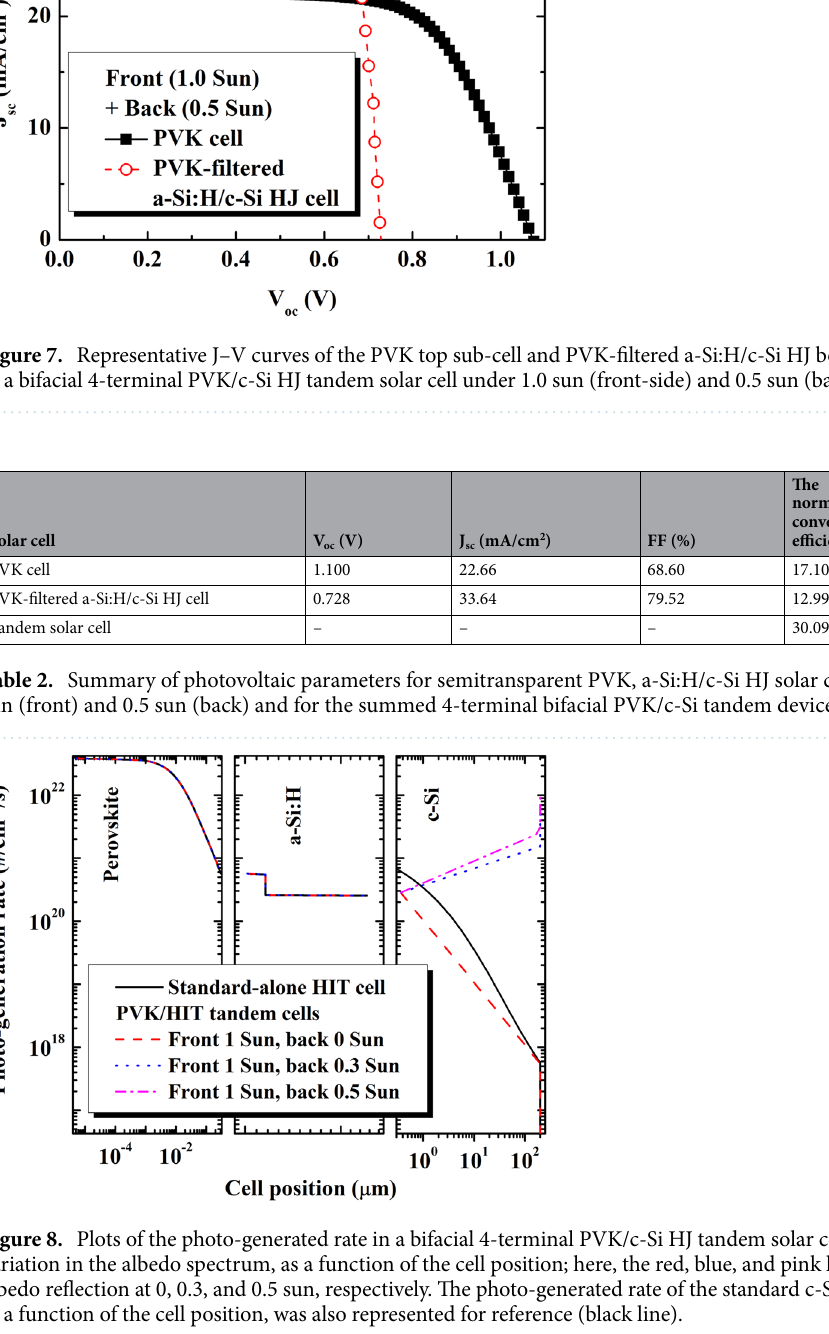
version efficiency. Figure 8 shows the simulated photo-generated rate distribution, which was determined using AFORS-HET software, within the PVK/c-Si HJ tandem solar cell under three selected conditions: without spec- tra albedo (dashed red line), with spectra albedo of 0.3 sun (dotted blue line) and with spectra albedo of 0.5 sun (dash-dotted magenta line). For reference purposes, the simulated photo-generated rate distribution inside the a-Si:H/c-Si HJ solar cell without a PVK filter (solid black line) is plotted as a function of the cell position. We observed that the bottom sub-cell of the PVK/HIT tandem solar cell without albedo reflection shows fewer